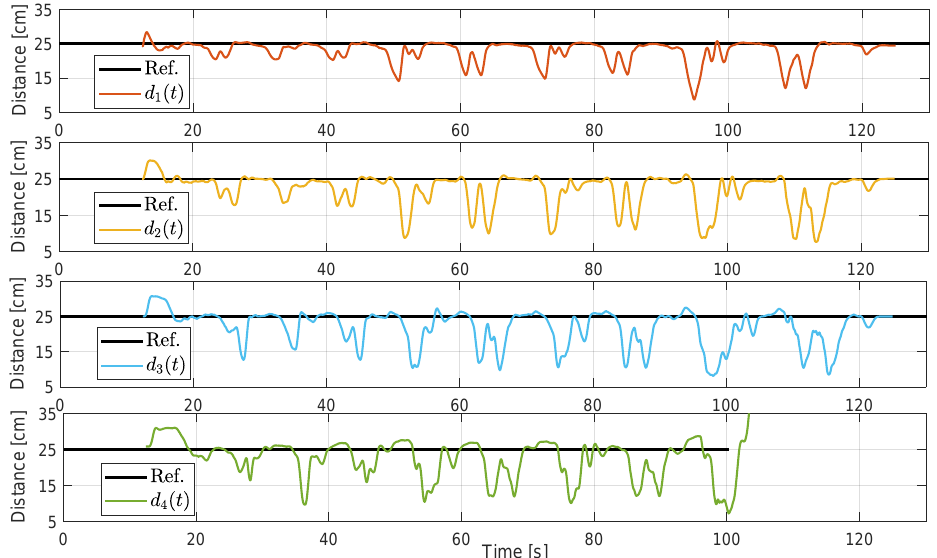
Figure 9. Distance tracking using the non-cooperative